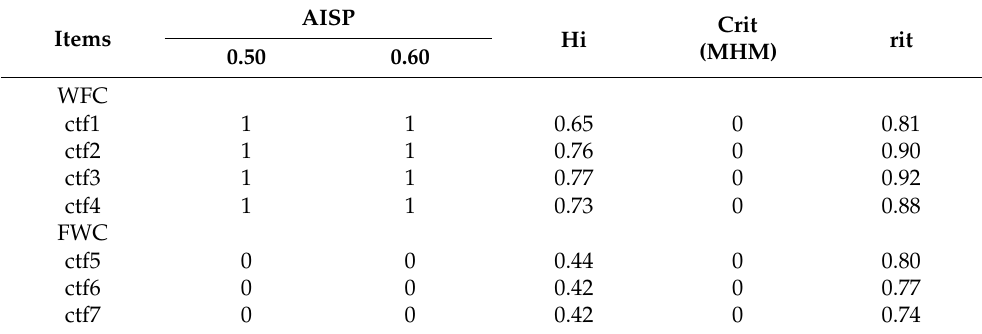
Table 3. Mokken analysis scaling: dimensionality, scalability, and monotonic